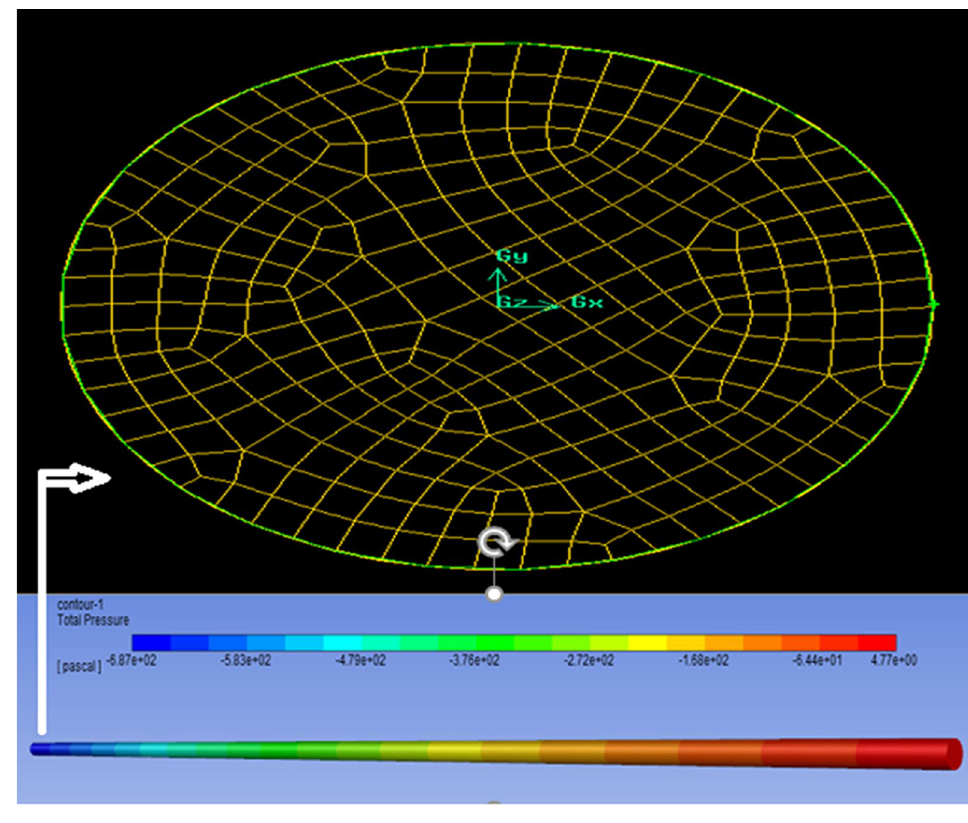
Figure 3. Schematic and mesh diagram of copper tube.